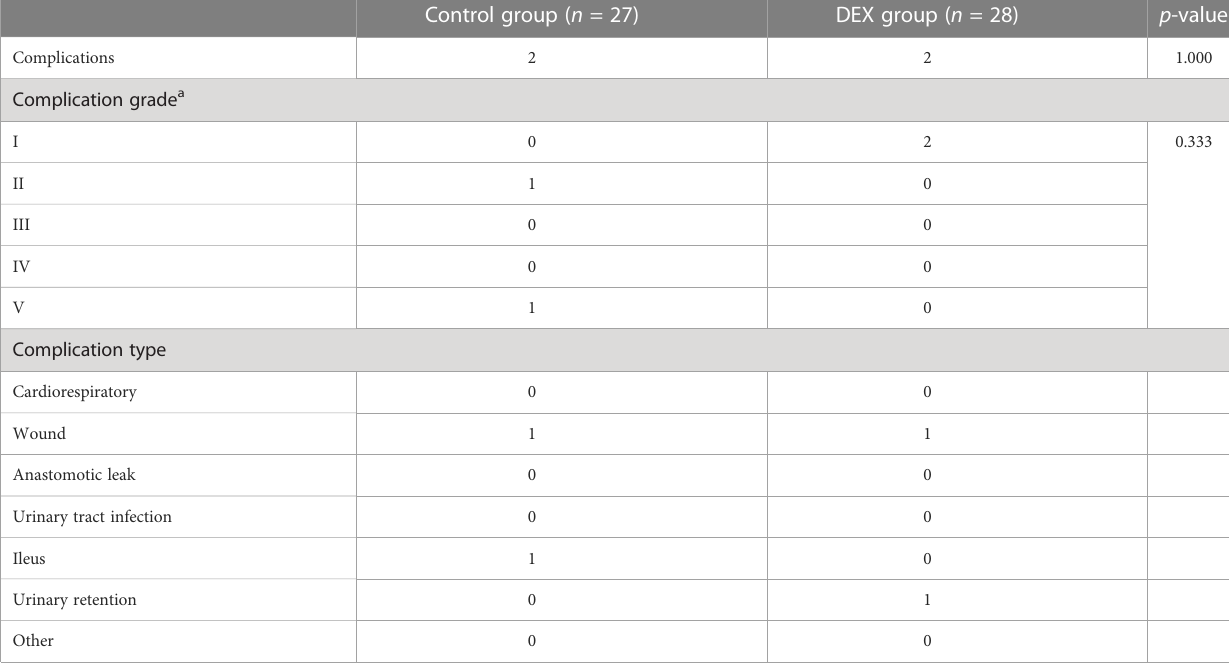
TABLE 3 Postoperative